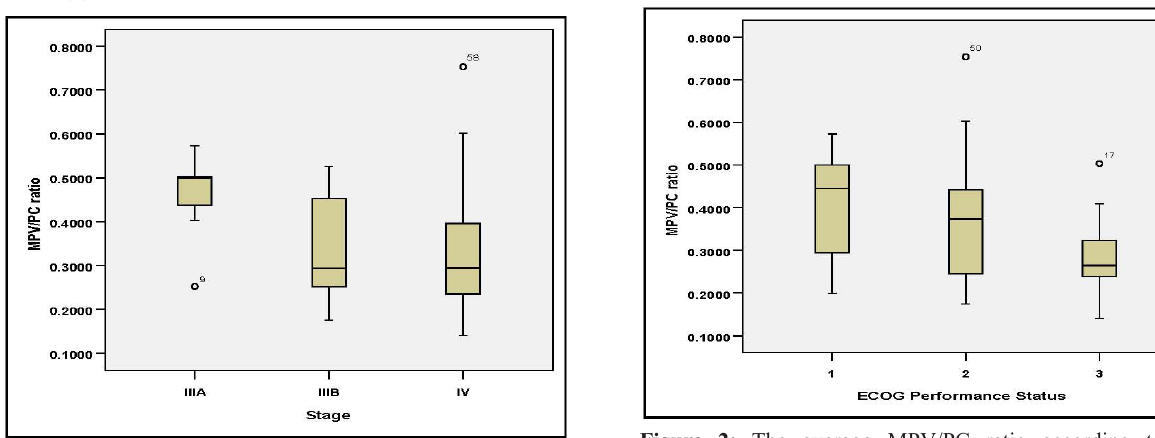
Figure 2: The average MPV/PC ratio according to the ECOG performance status of patients with advanced NSCLC ( p